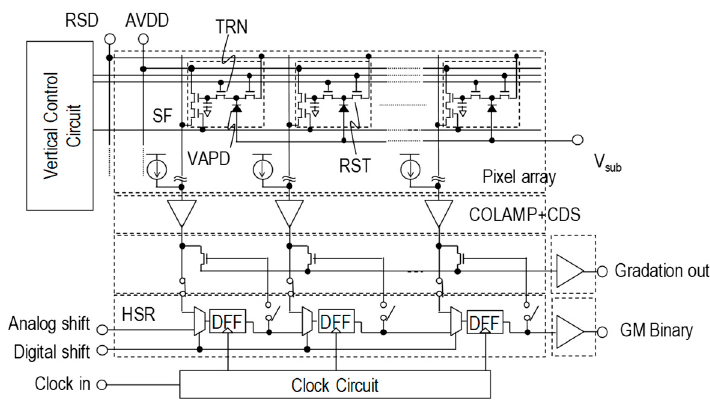
Figure 5. A block diagram of the developed CMOS image sensor (CIS).